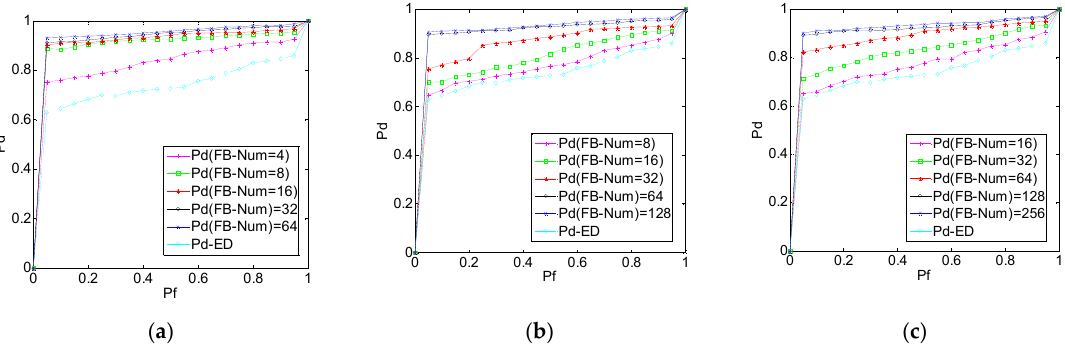
Figure 9. ROC curve for sub-bands with different ISPs. ( a ) ISP is 12.27%; ( b ) ISP is 47.51%; ( c ) ISP is